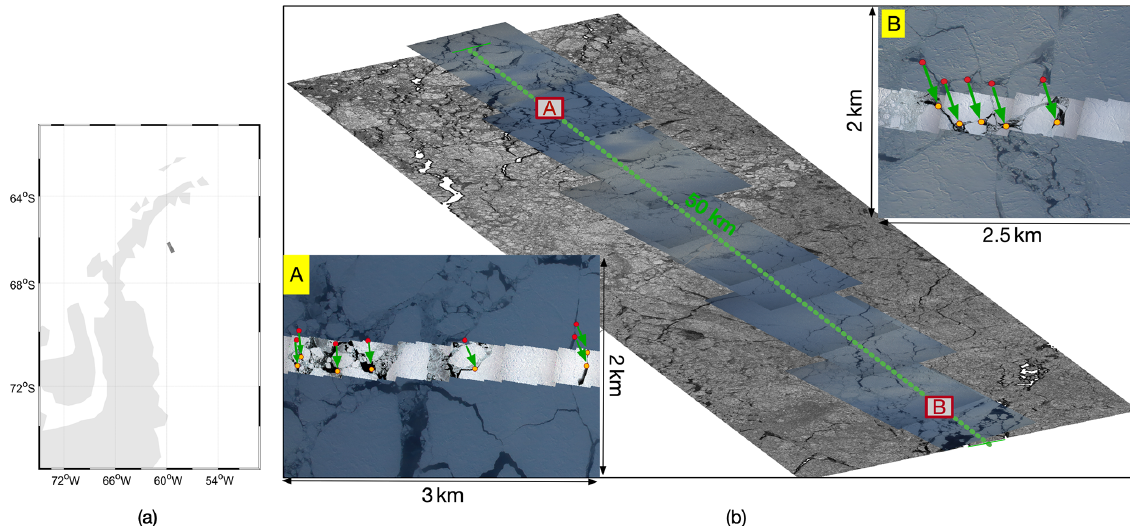
Figure 2. (a) Geolocation of the study area (the grey rectangle). (b) Composite of the SAR intensity image in HH polarization and the airborne digital mapping system (DMS) digital camera images. The green dashed line indicates the 50km transect of the DMS DEM data. Sub-image A and sub-image B are close-ups of area A and area B with small-scale DMS images (acquired at around 17:50UTC) superimposed on the large-scale DMS images (acquired at around 22:05UTC). The red and yellow dots denote the selected reference pairs from the large- and small-scale DMS image, respectively. The green arrow denotes the shift vector, which is used for data